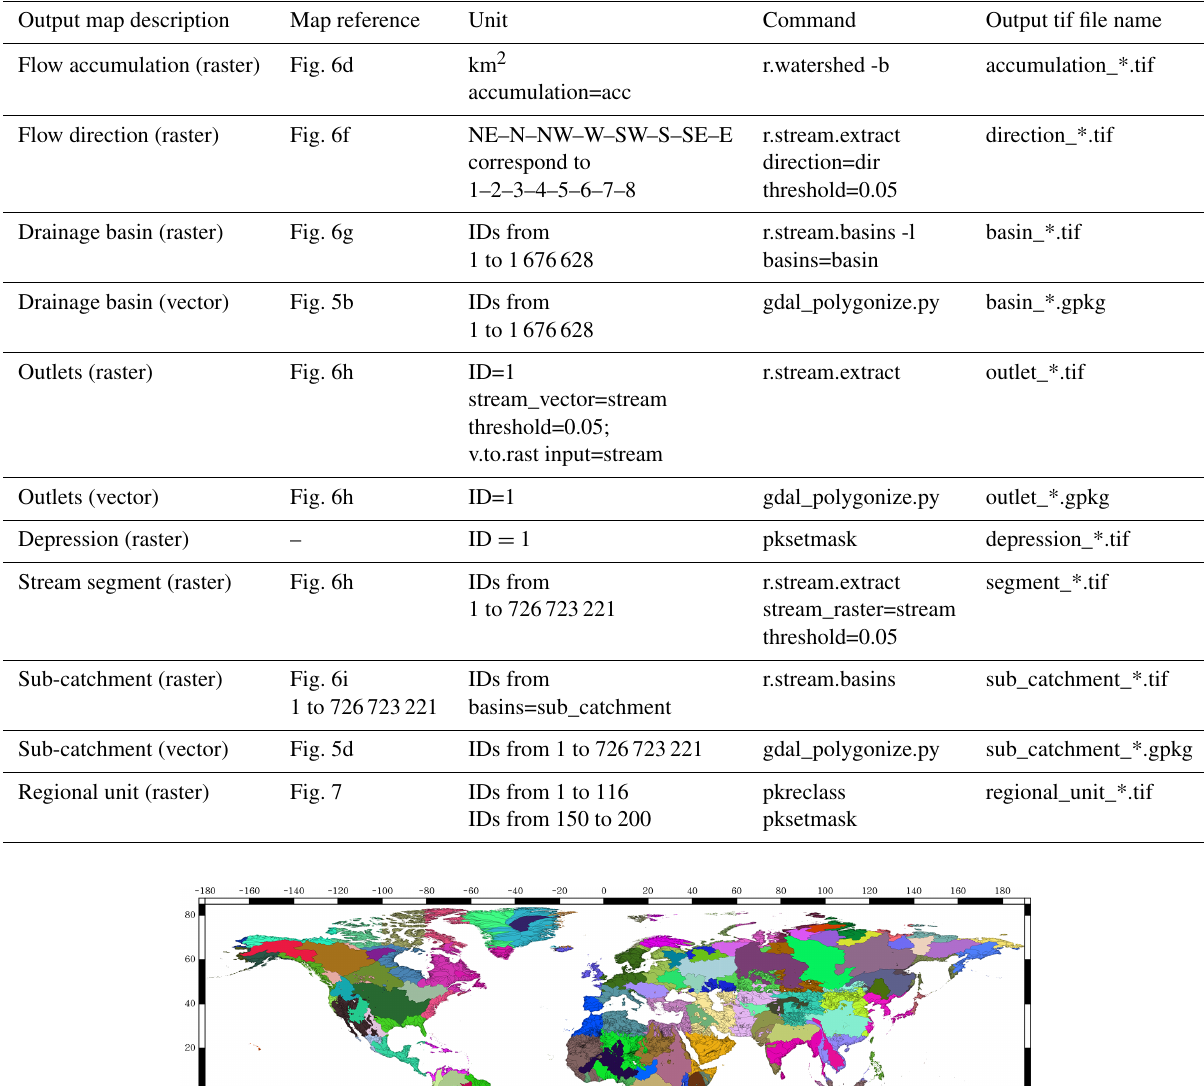
Table 1. Base and network layers of Hydrography90m: flow accumulation, flow direction, drainage basins, outlets, stream segments, sub- catchments, regional units, and depression; Map reference corresponding to Fig. 6 for raster visualisation and Fig. 5 for vector visualisation; Unit; Commands for computation; and Output file names. The asterisk stands for the regular tile ID for downloading the data, available in 20 ◦ × 20 ◦ tiles (Fig. 3).